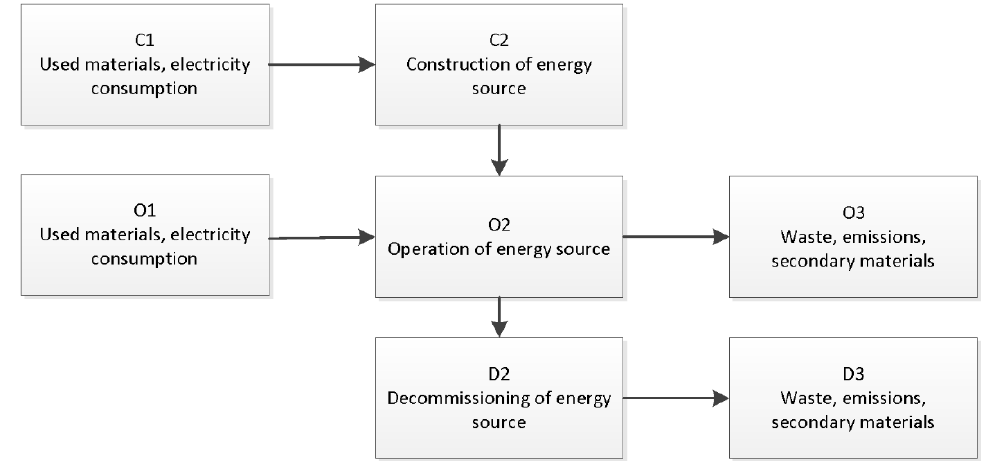
Figure 1. The system boundaries applied in the study.